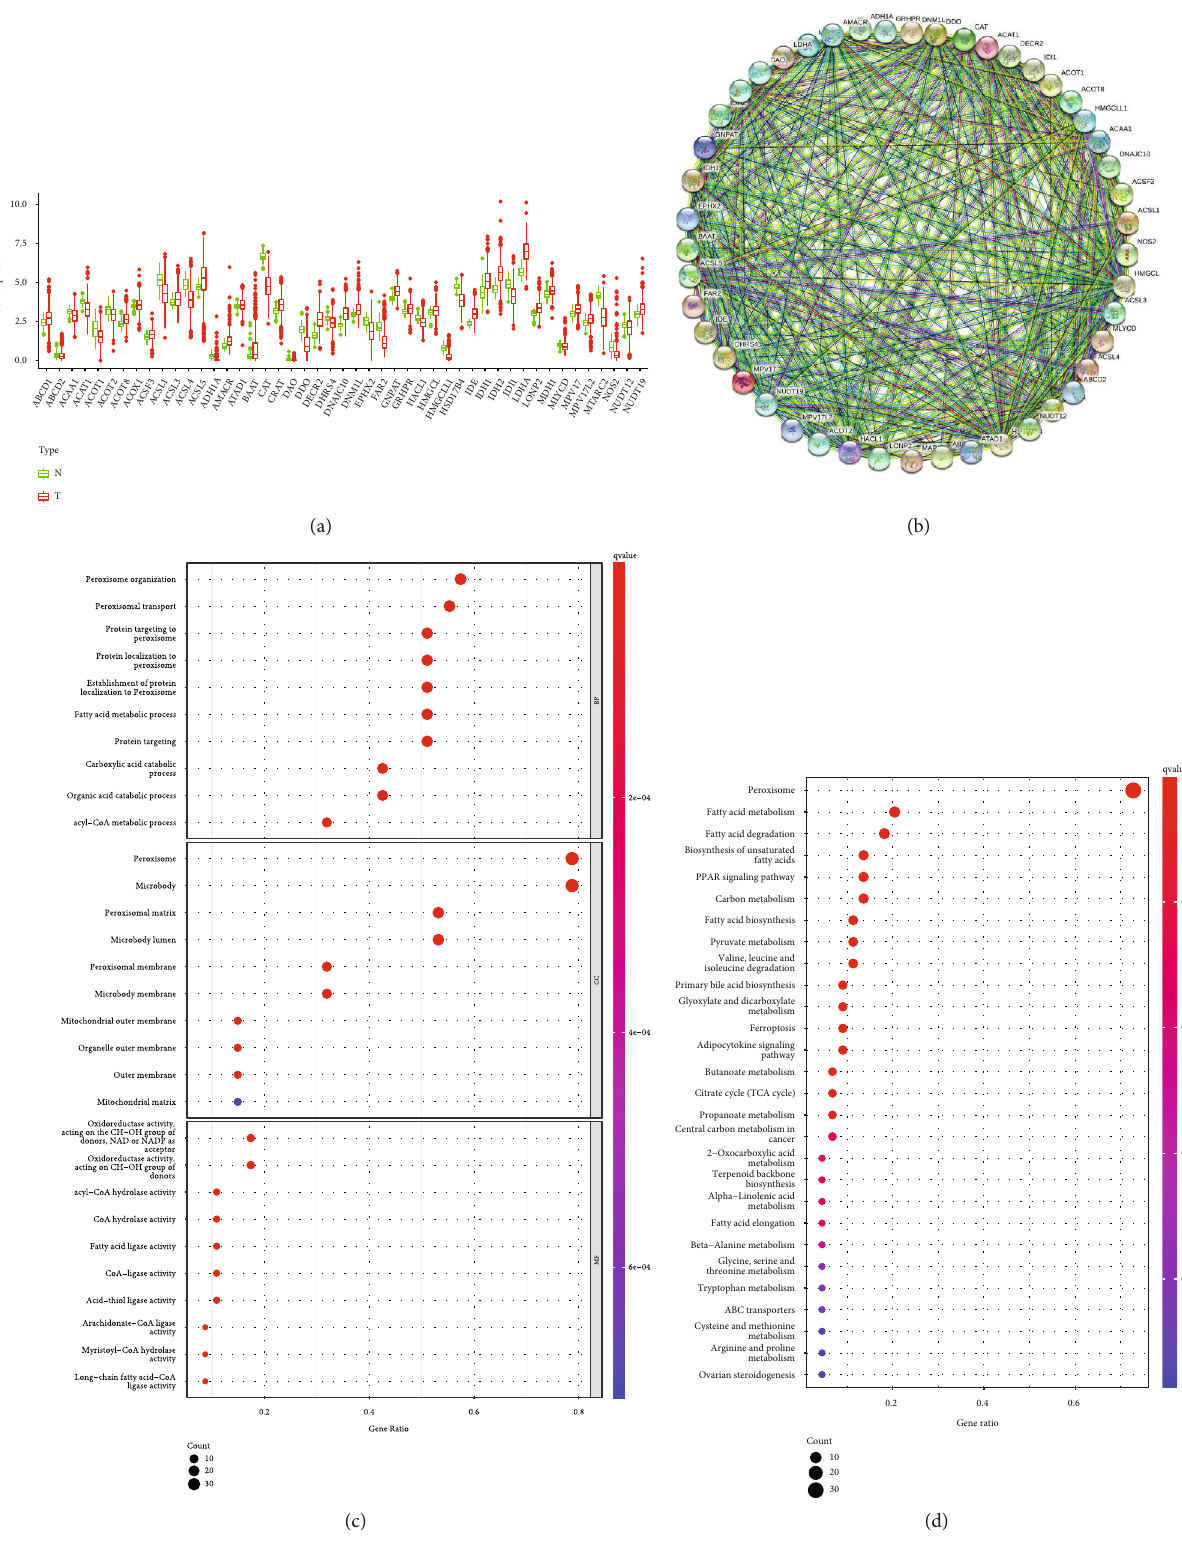
Figure 1: Di ff erentially expressed PRGs and their functional enrichment analysis. (a) Expression of 47 PRGs. (b) Interaction of di ff erentially expressed PRGs ’ protein. (c) GO analysis of di ff erentially expressed PRGs. (d) KEGG analysis of di ff erentially expressed PRGs. N: normal; T: